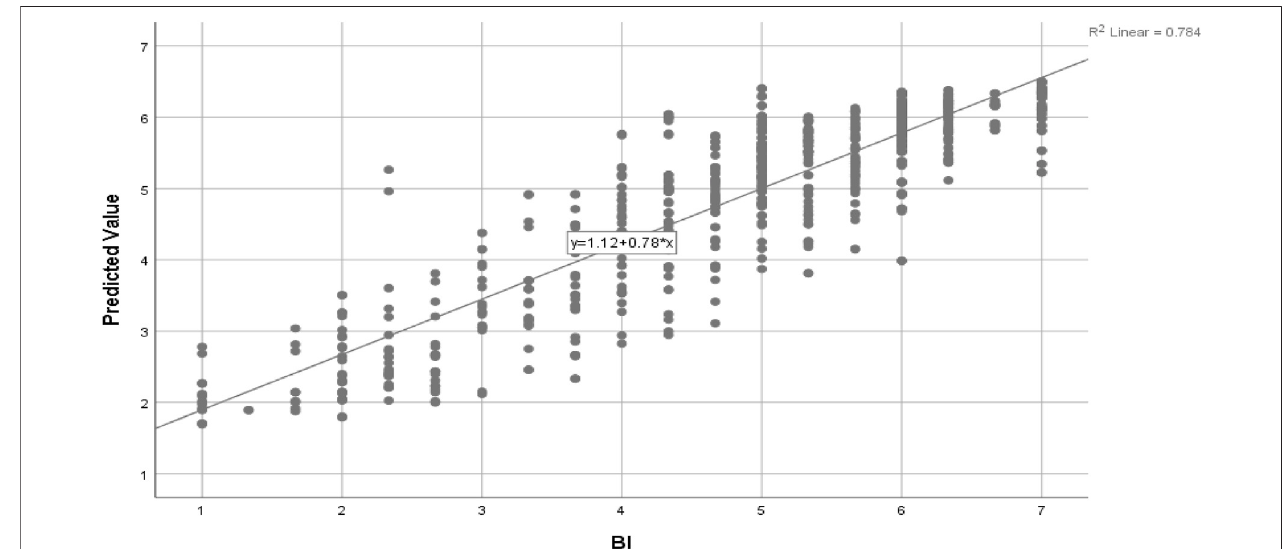
FIGURE 5 | Regression standard residuals.